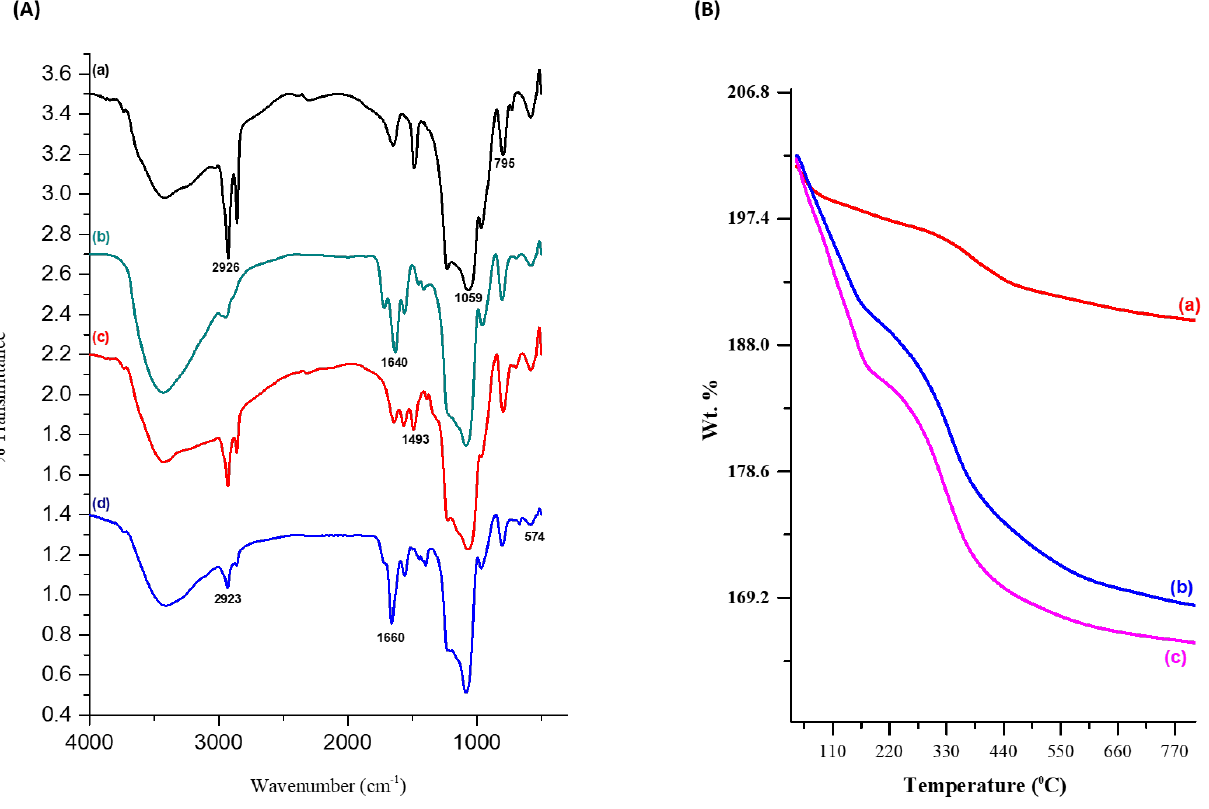
Figure 3. ( A ) FT-IR analysis of ( a ) CuMSN-Unextd, ( b ) CuMSN-extd, ( c ) CuMSN@DOX, and ( d